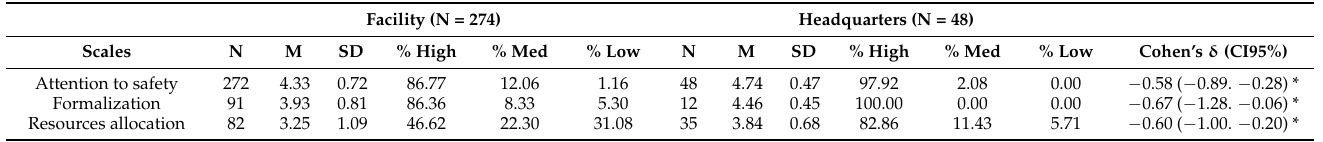
Table 9. Descriptive statistics of the BARS by work location.